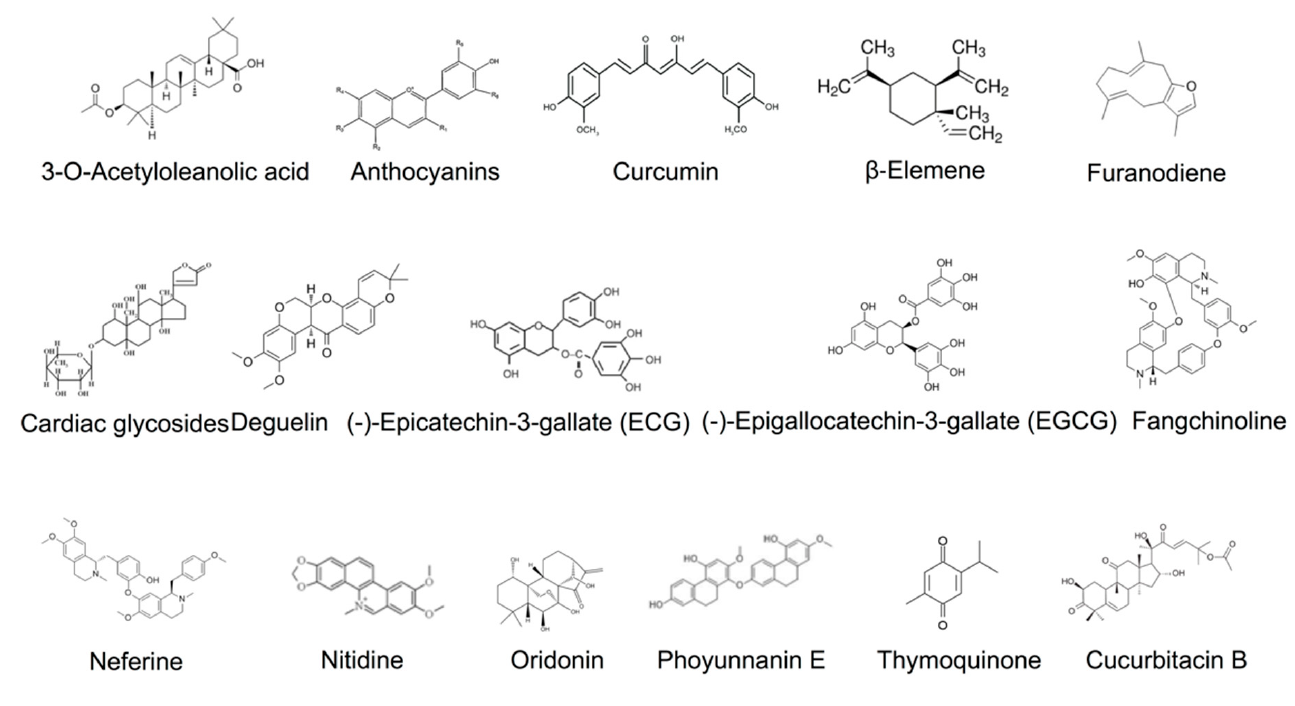
Figure 2. Potential FAK inhibitors from natural sources. Table 1. FAK inhibitors from natural